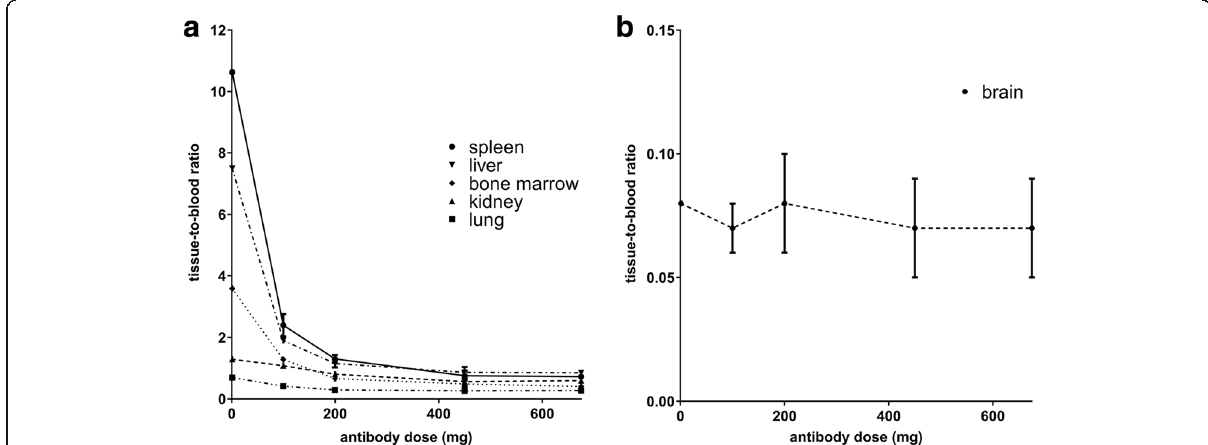
Fig. 4 Tissue-to-blood AUC ratio of RG7356 as a function of antibody dose. a Ratios for spleen, liver, bonemarrow, kidney and lung. b Ratio for brain. Data is presented as mean; error bars represent